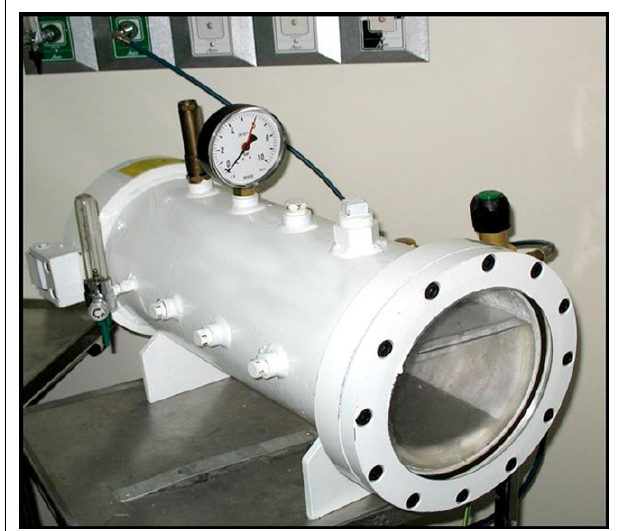
FIGURE 1 | Hyperbaric oxygen chamber designed for mice. The mice can be seen through the windows during